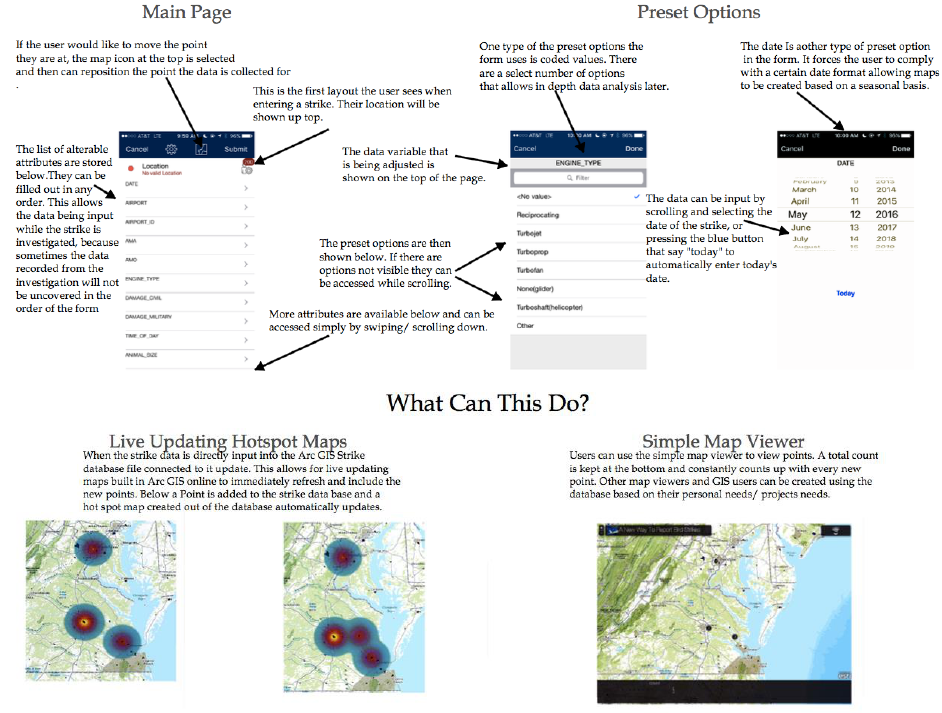
Figure 4. Bird Strike Collector Project Example (http://www.isat.jmu.edu/geospatialsemester/15-